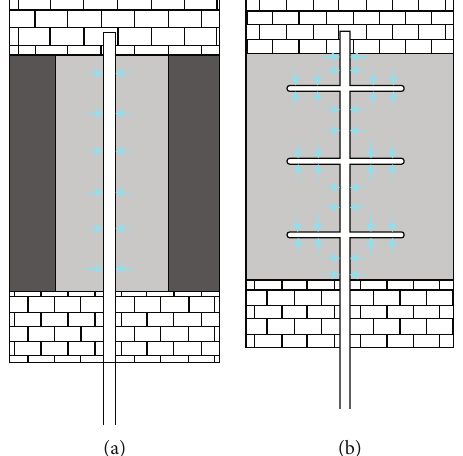
Figure 4: Gas fl ow around one borehole. (a) Schematic diagram of gas fl ow in ordinary boreholes. (b) Schematic diagram of gas fl ow in slotted